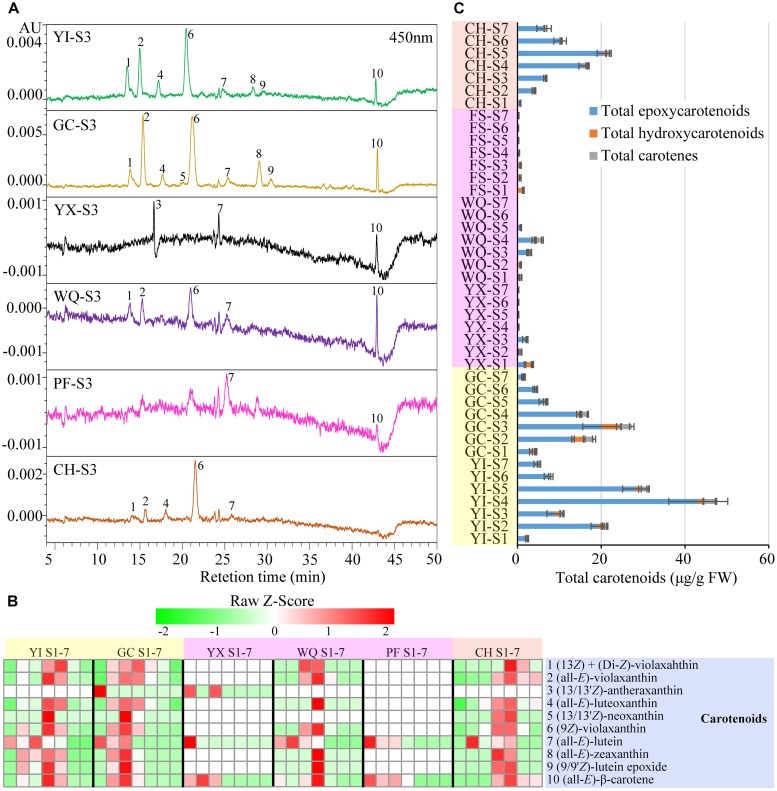
Contents of flavonols extracted from rose petals of six cultivars at different developing stages. (A) HPLC chromatograms of flavonols (detection at 350 nm): 1, kaempferol 3-O-rhamnoside-7-O-glucoside; 2, quercetin 3-O-glycoside; 3, quercetin 7-O-glucoside; 4, flavan-3-ol derivative; 5, kaempferol 3-O-rutinoside; 6, kaempferol 3-O-glucoside; 7, kaempferol 3-O-glucuronide; 8, kaempferol 3-O-(galloyl)-glucoside; 9, quercetin 7-O-rhamnoside; 10, kaempferol 3-O-xyloside; 11, kaempferol 7-O-glucoside; 12, kaempferol 3-O-arabinoside; 13, kaempferol 3-O-hexoside; 14, kaempferol 3-O-rhamnoside; 15, kaempferol 3-O-glycoside 1; 16, kaempferol 3-O-glycoside 2; 17, kaempferol 7-O-(galloyl)-glucoside; 18, kaempferol 3-O-glycoside 3; 19, kaempferol 3-(p-coumaroyl)-glucoside; 20, kaempferol. (B) A heat map of the individual flavonol contents. Row represents Z-Score normalization of the concentation of identified flavonols and column represents tested samples. Cells are colored based on concentrations in rose petals. Red represents relatively high concentration and green represents relatively low concentration of the identified flavonols in petals of each rose cultivar at seven developing stages. Each value represents the average of three biological replicates. (C) The concentration of total flavonols. Data represent the means of three biological replicates ± SD.